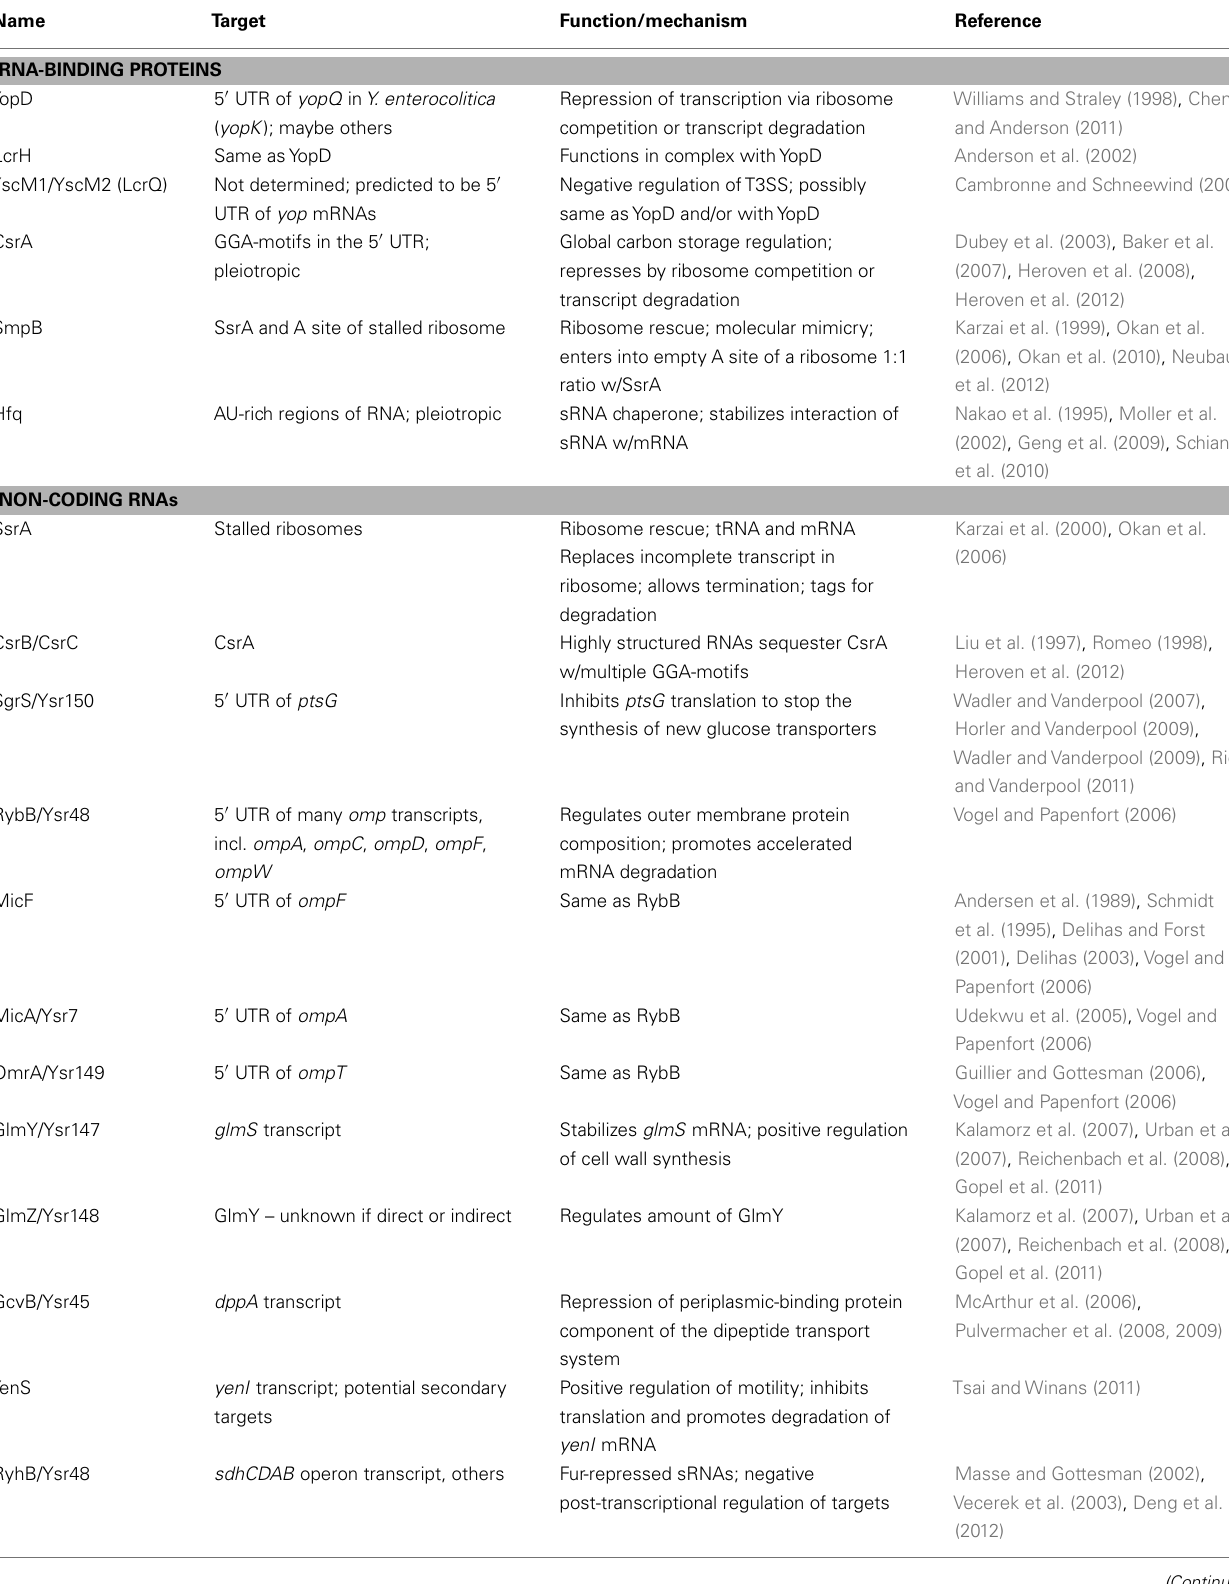
Table 1 | Post-transcriptional regulators, targets, and functions in Yersinia